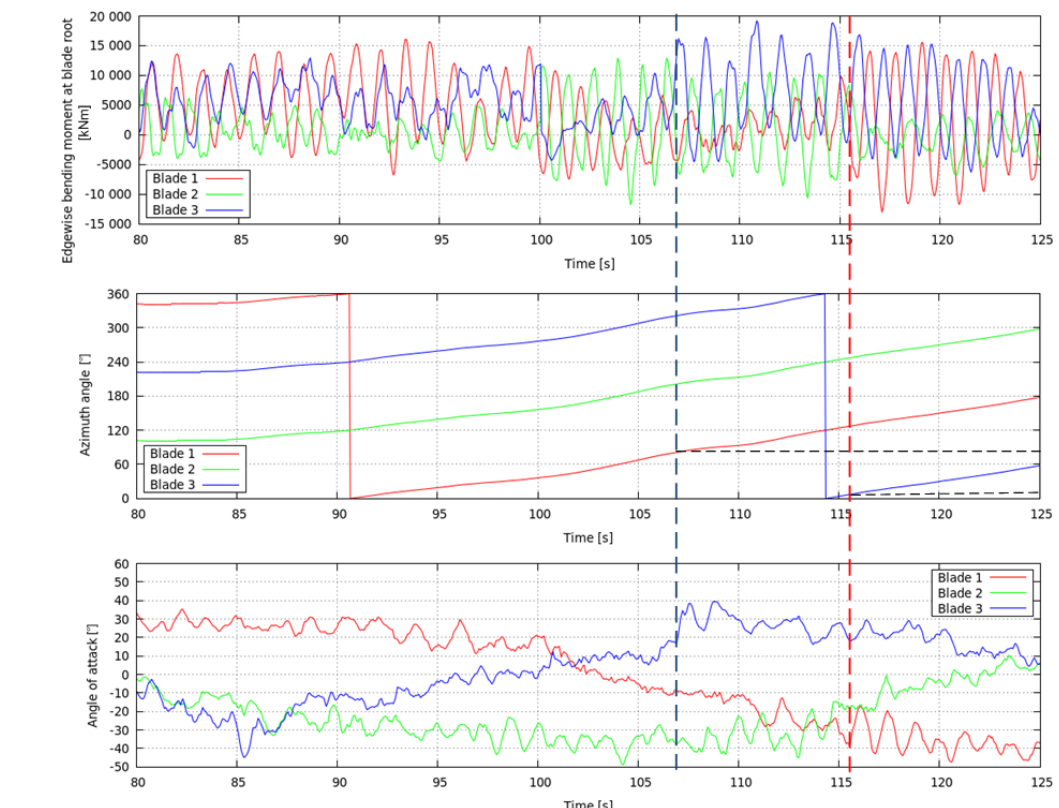
Figure 13. Times series of blade root edgewise bending moment with the blade azimuth angle and angle of attack at r/R = 0 . 90 spanwise position. Wind speed 42.5ms − 1 ; TI 11%; yaw angle 30 ◦ .